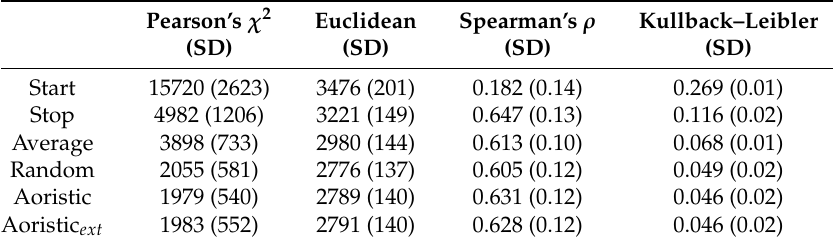
Table 4. Mean and standard deviation for the four evaluation measures and six temporal analysis methods that were evaluated with the hour data over each of the five